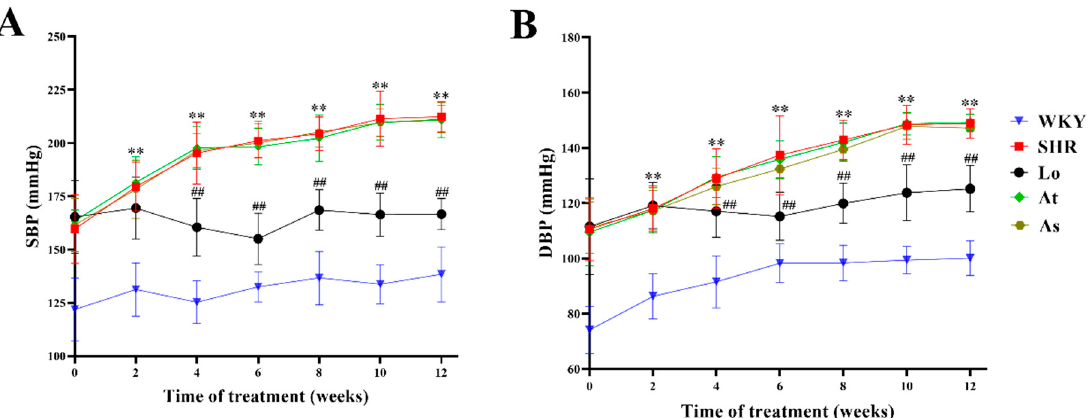
Figure 1. Blood pressure changes in WKY, SHR, SHR-Losartan (Lo), SHR-Atorvastatin (At), and SHR-Aspirin (As) groups. ( A ) Systolic blood pressure (SBP). ( B ) Diastolic blood pressure (DBP). The data are presented as the mean ± standard deviation (SD), n = 6. ** p < 0.01 vs. WKY; ## p < 0.01 vs. untreated SHR.